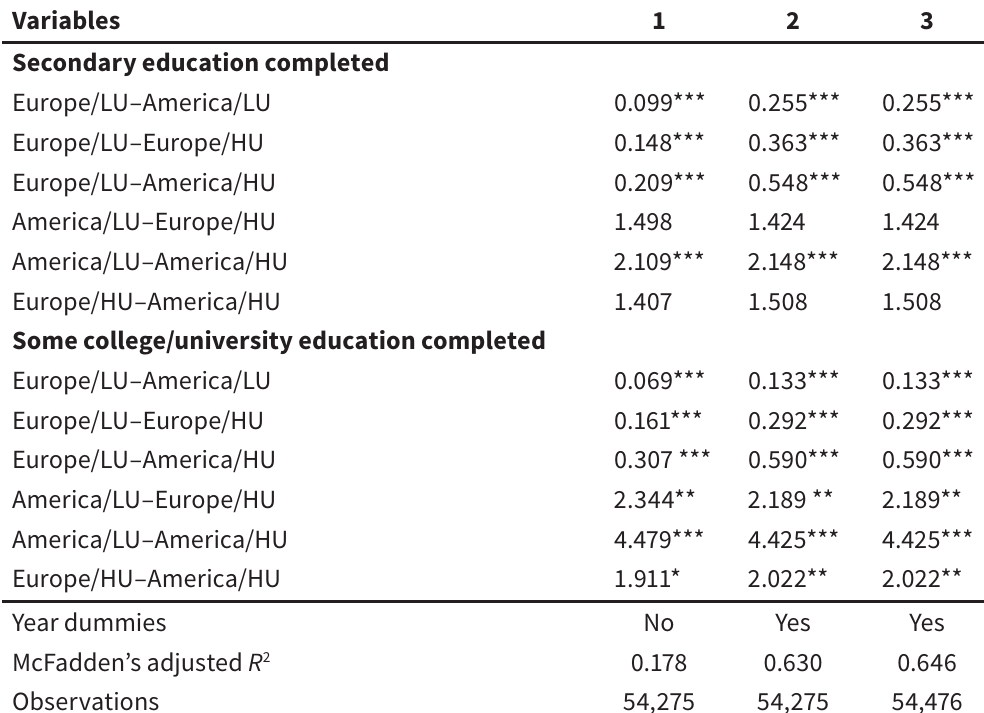
Location choice: destination countries classified by URs and continents Variables